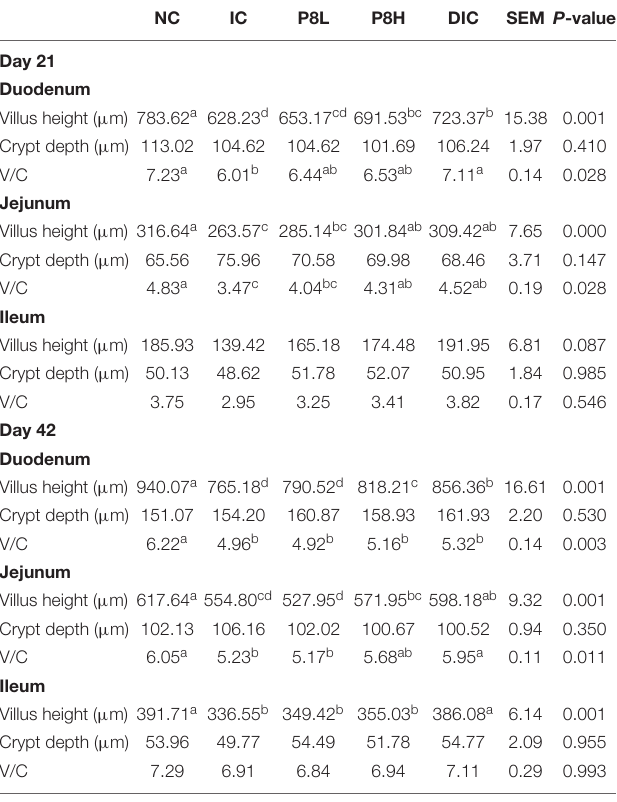
TABLE 4 | Effects of P8 on the intestinal morphology of Eimeria -infected broilers at days 21 and 42.